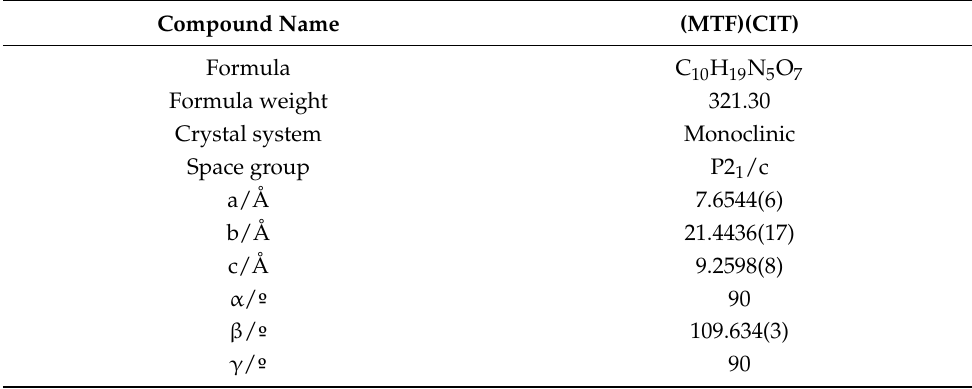
Table 1. Crystallographic data and structure refinement details of the MFT–CIT